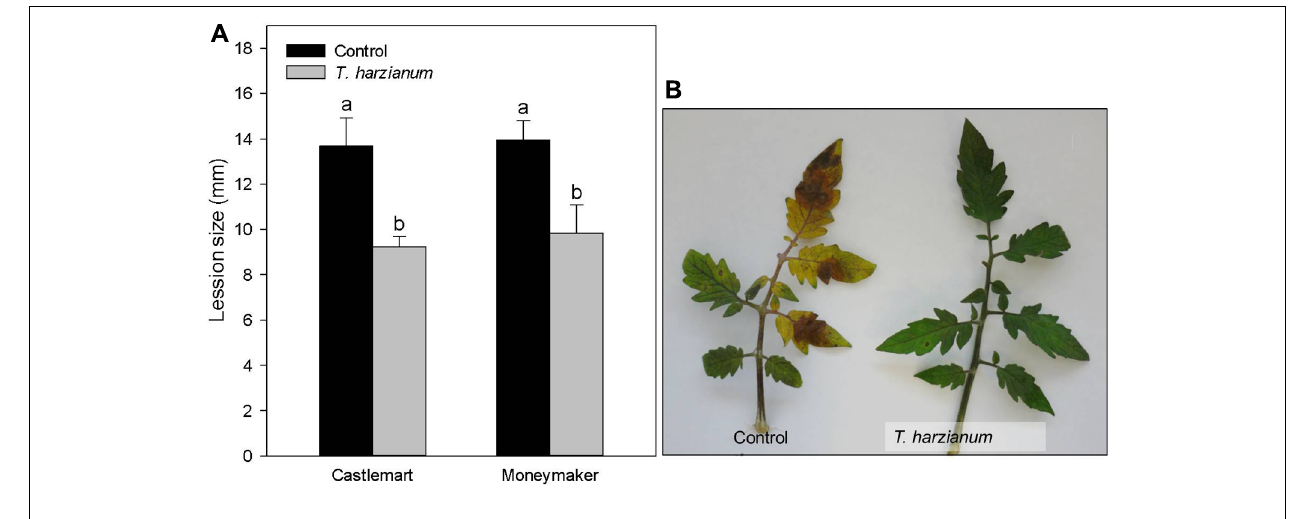
inoculation.The data show the lesion diameter (mm) ±SE (n = 12). Data not sharing a letter in common differ significantly ( P < 0.05) according to Tukey’s multiple-range test. (B) B. cinerea symptom development in T. harzianum inoculated and non-inoculated (control) plants (cv. Moneymaker).